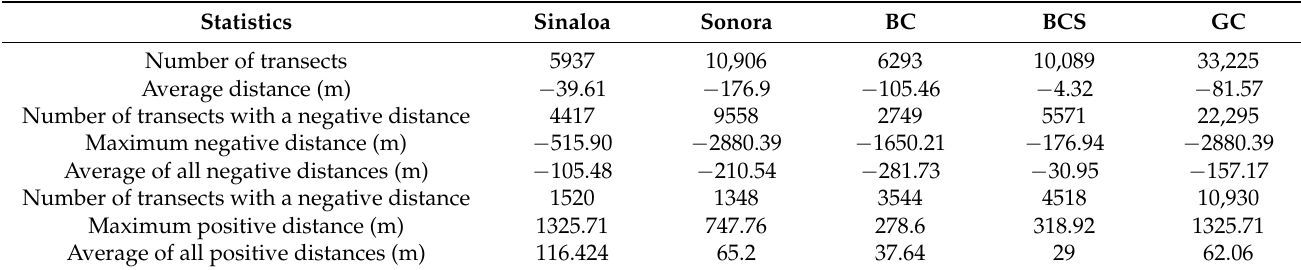
Table 2. Shoreline changes by NSM.